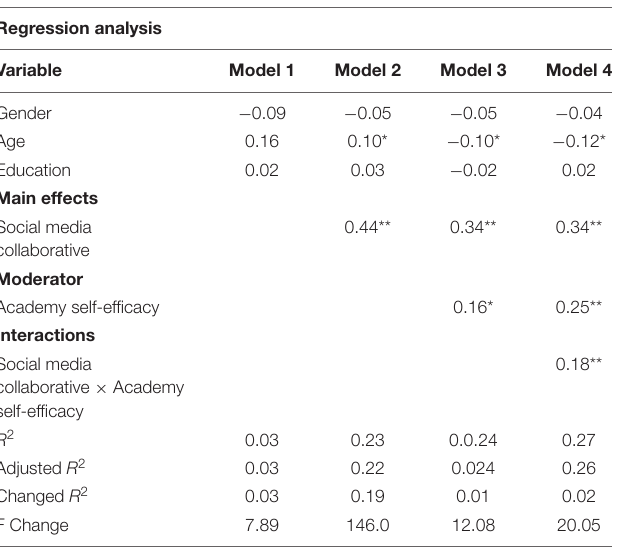
TABLE 5 | Results of hierarchical regression.